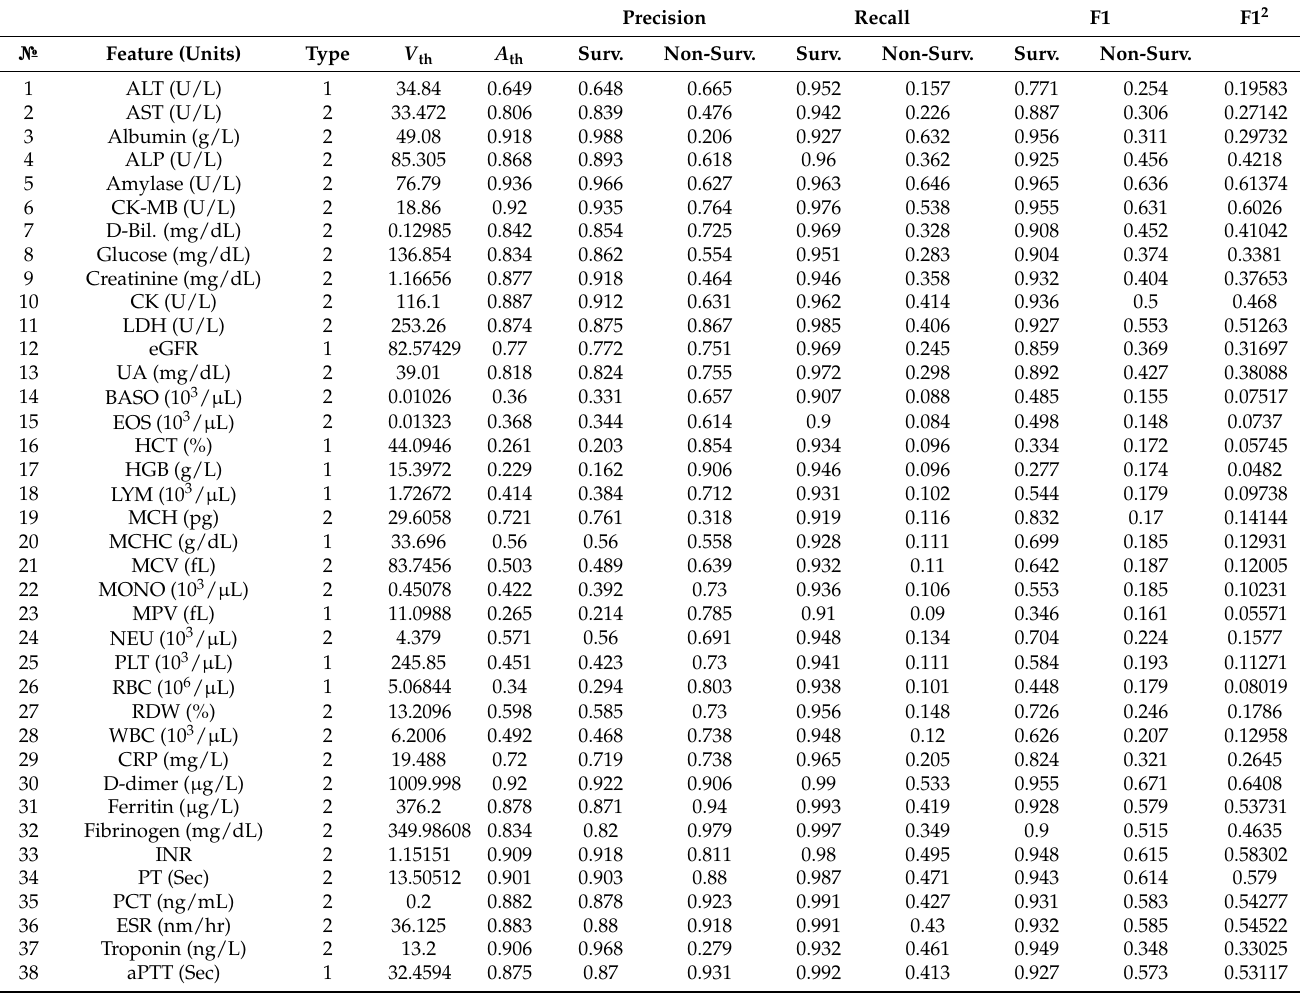
Table A2. Results of classification according to the one-threshold approach of surviving and non- surviving COVID-19 patients, for the balanced dataset.